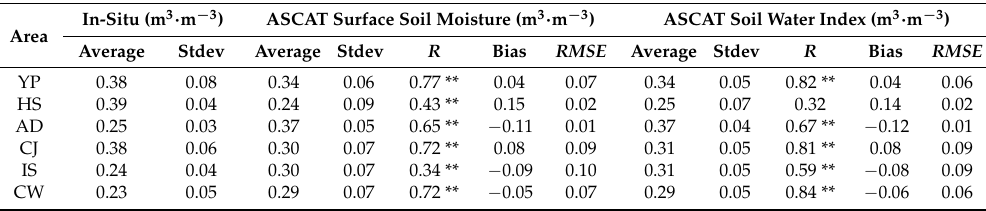
Table 2. Comparison of in situ data, ASCAT SSM, and ASCAT SWI ( T = 20) from 1 May to 30 September